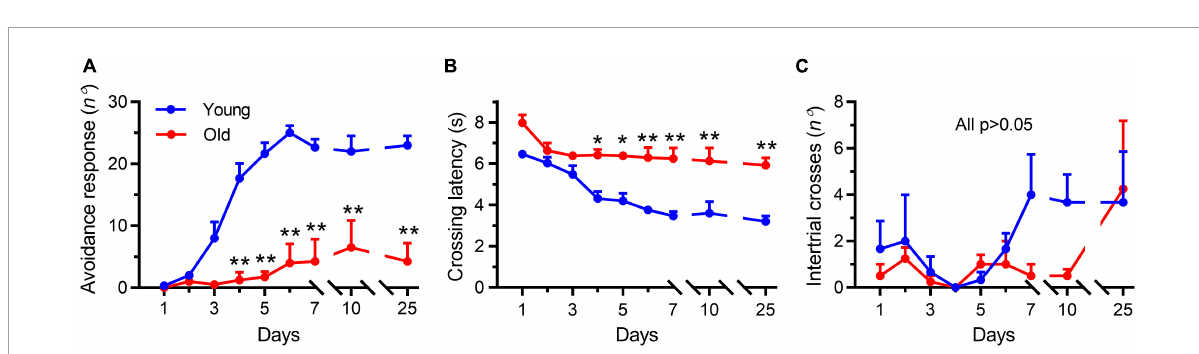
FIGURE2 Aging impaired the active avoidance performance in male mice. Data shown are means with SEM. (A) Progression of active avoidance responses during the training phase. Aged mice (Old) did not increase the number of avoidance responses during the training phase (** p < 0.001). (B) Time course of crossing latencies for aged mice (Old) during the training phase. Old mice did not decrease escape latency during training (* p < 0.01, ** p < 0.001). (C) Number of intertrial crosses. From day 1, there was no significant difference between young and aged mice (Old) in the number of intertrial crosses. Statistics were performed with repeated-measures two-way ANOVA, followed by post-Bonferroni’s test, n = 3–4 per